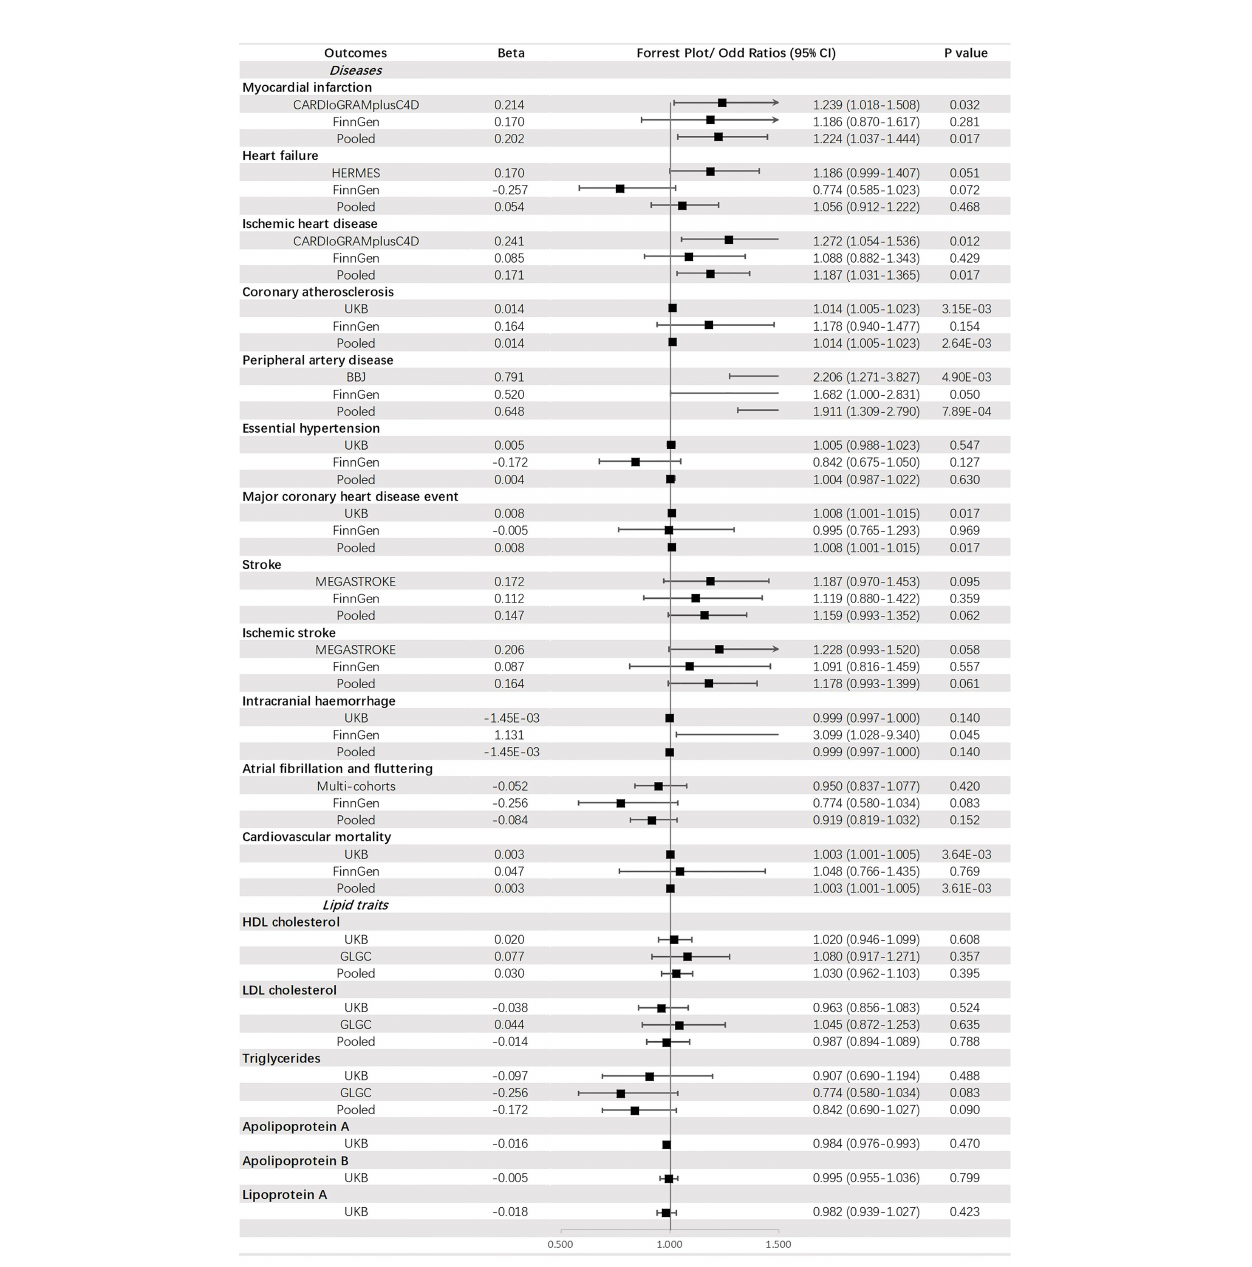
FIGURE 4 | The association between fasting glucose (mmol/mol) and